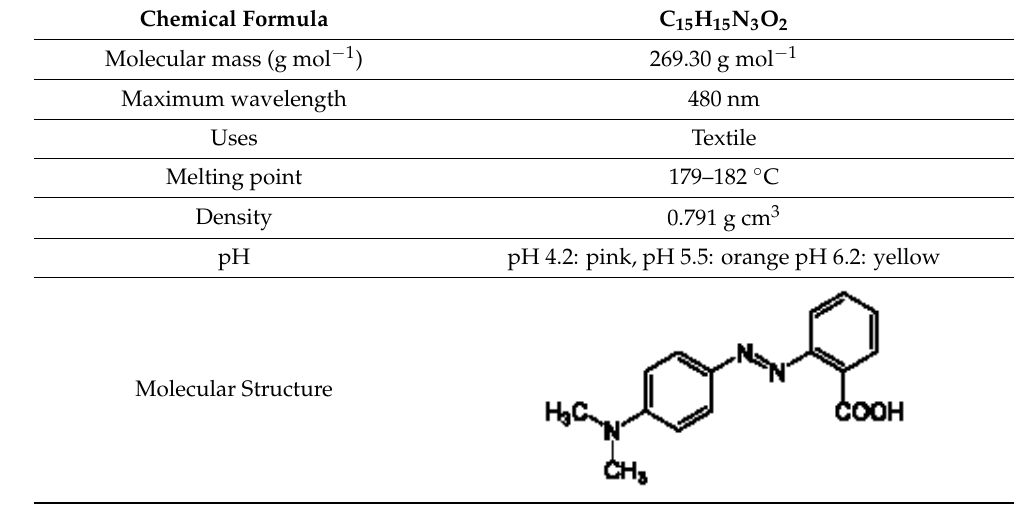
Table 1. Properties of methyl orange dye.